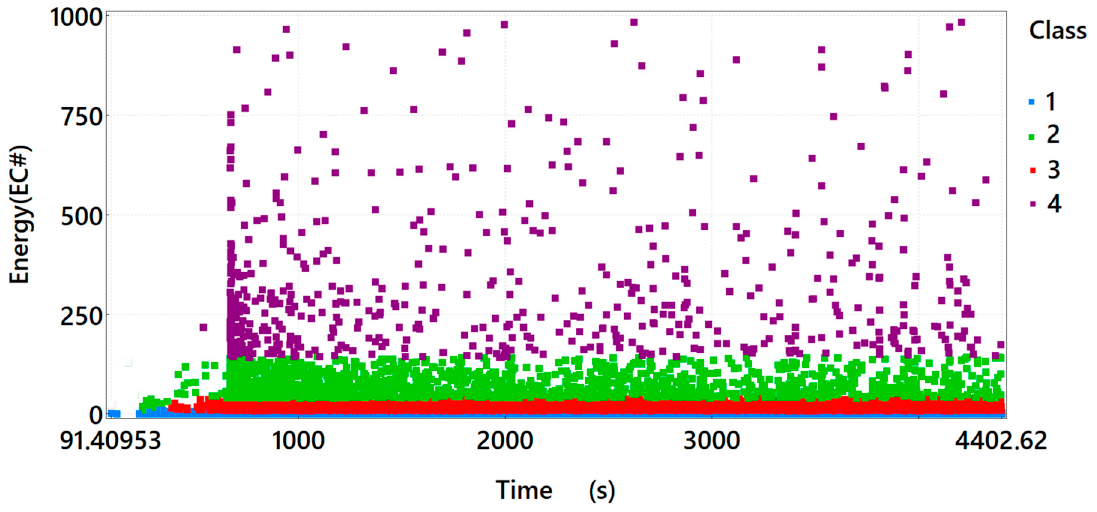
Figure 5. Graph of energy in time, taking into account the division of the recorded signals of acoustic emission into classes for sample A 3 .